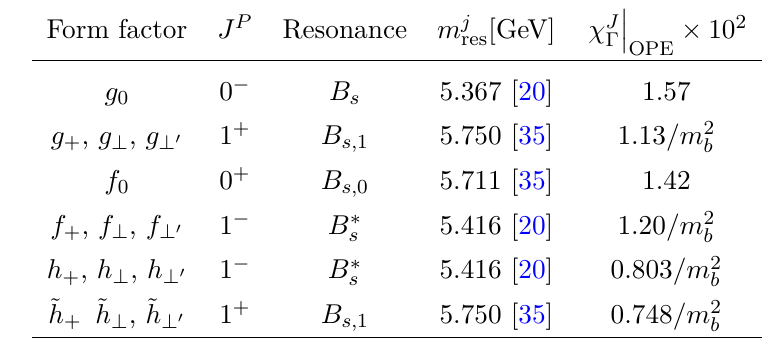
. In blue we indicate the relevant +